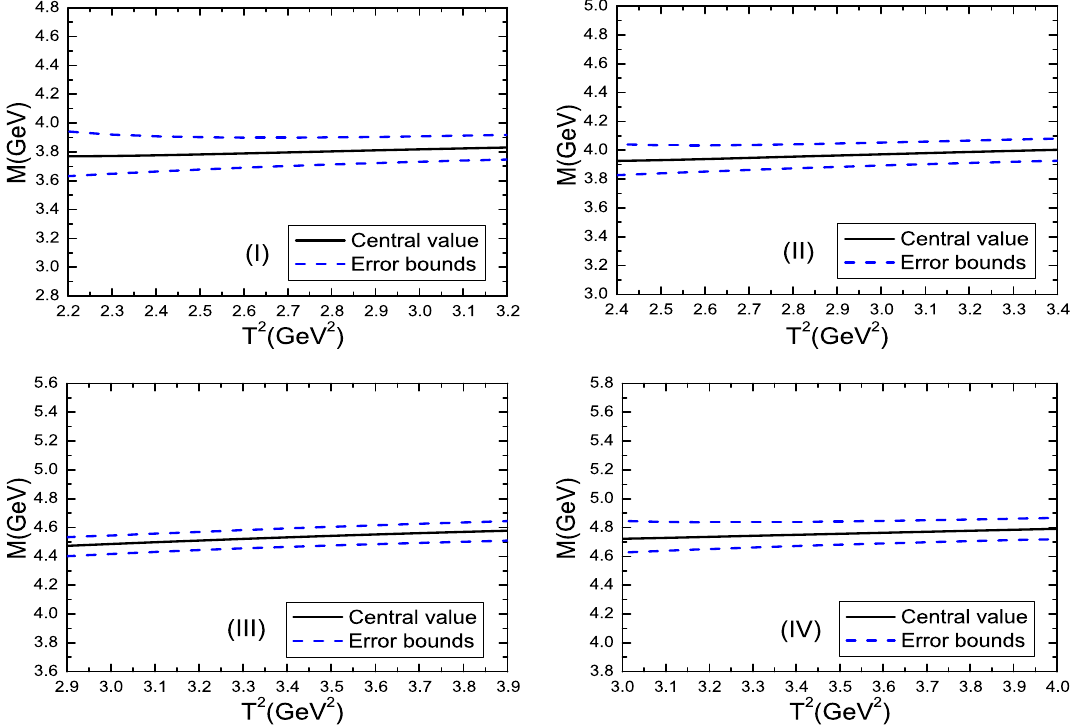
− ) − ) + ) + ) , ( sssc ¯ s , 3 , ( uuuc ¯ u , 3 , and ( sssc ¯ s , 3 , respectively 2 2 2 2